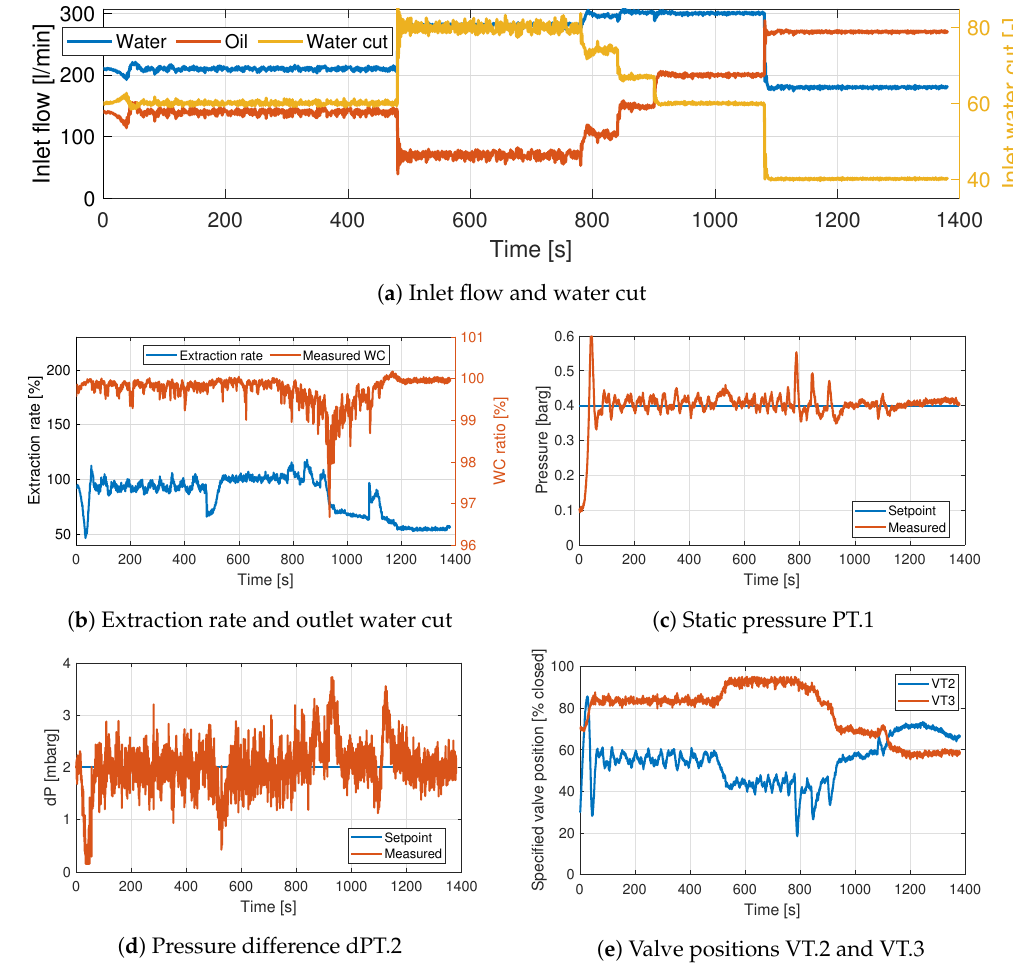
Figure 9. Experiment 3. PI controllers on VT.2 and VT.3 with VT.2 controlling PT.1 and VT.3 controlling